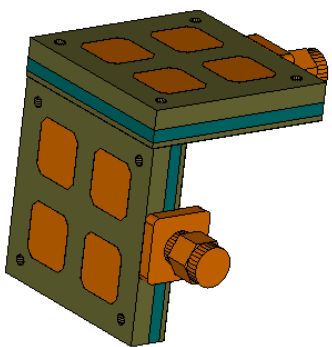
Figure 2. Alternative WBMA structure with the two subarrays assembled orthogonally.